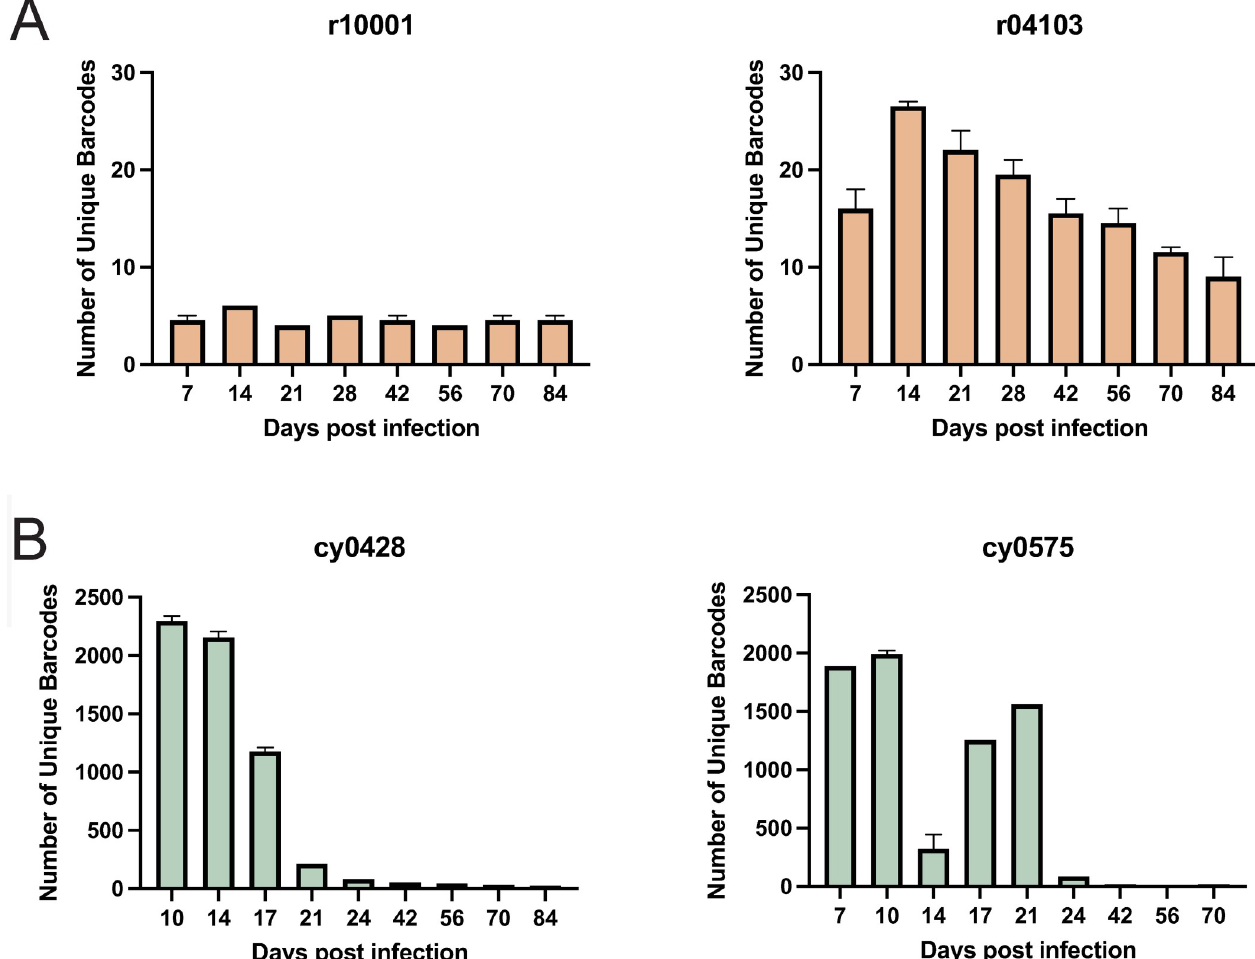
Fig 2. The number of unique viral lineages in IR and IV-challenged macaques. The number of unique viral lineages in intrarectally (IR)-challenged rhesus macaques (A) and intravenously (IV)-challenged cynomolgus macaques (B) between 7 and 84 days post-SIVmac239M infection. When duplicates were present, the median with 95% confidence interval was plotted. When only a single data point was present, that value was